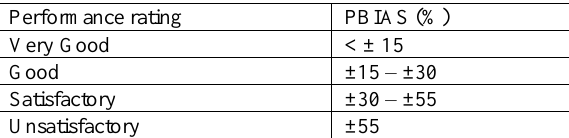
Table 3. Performance rating of CHIRPS data (Shrestha et al.,